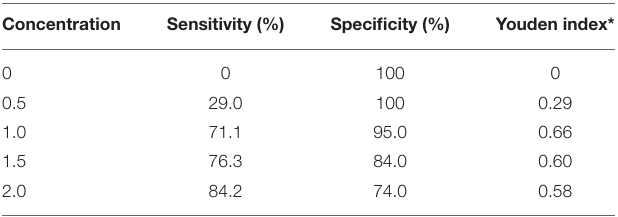
TABLE 2 | Performances on sera using different test capture reagent (rEno)